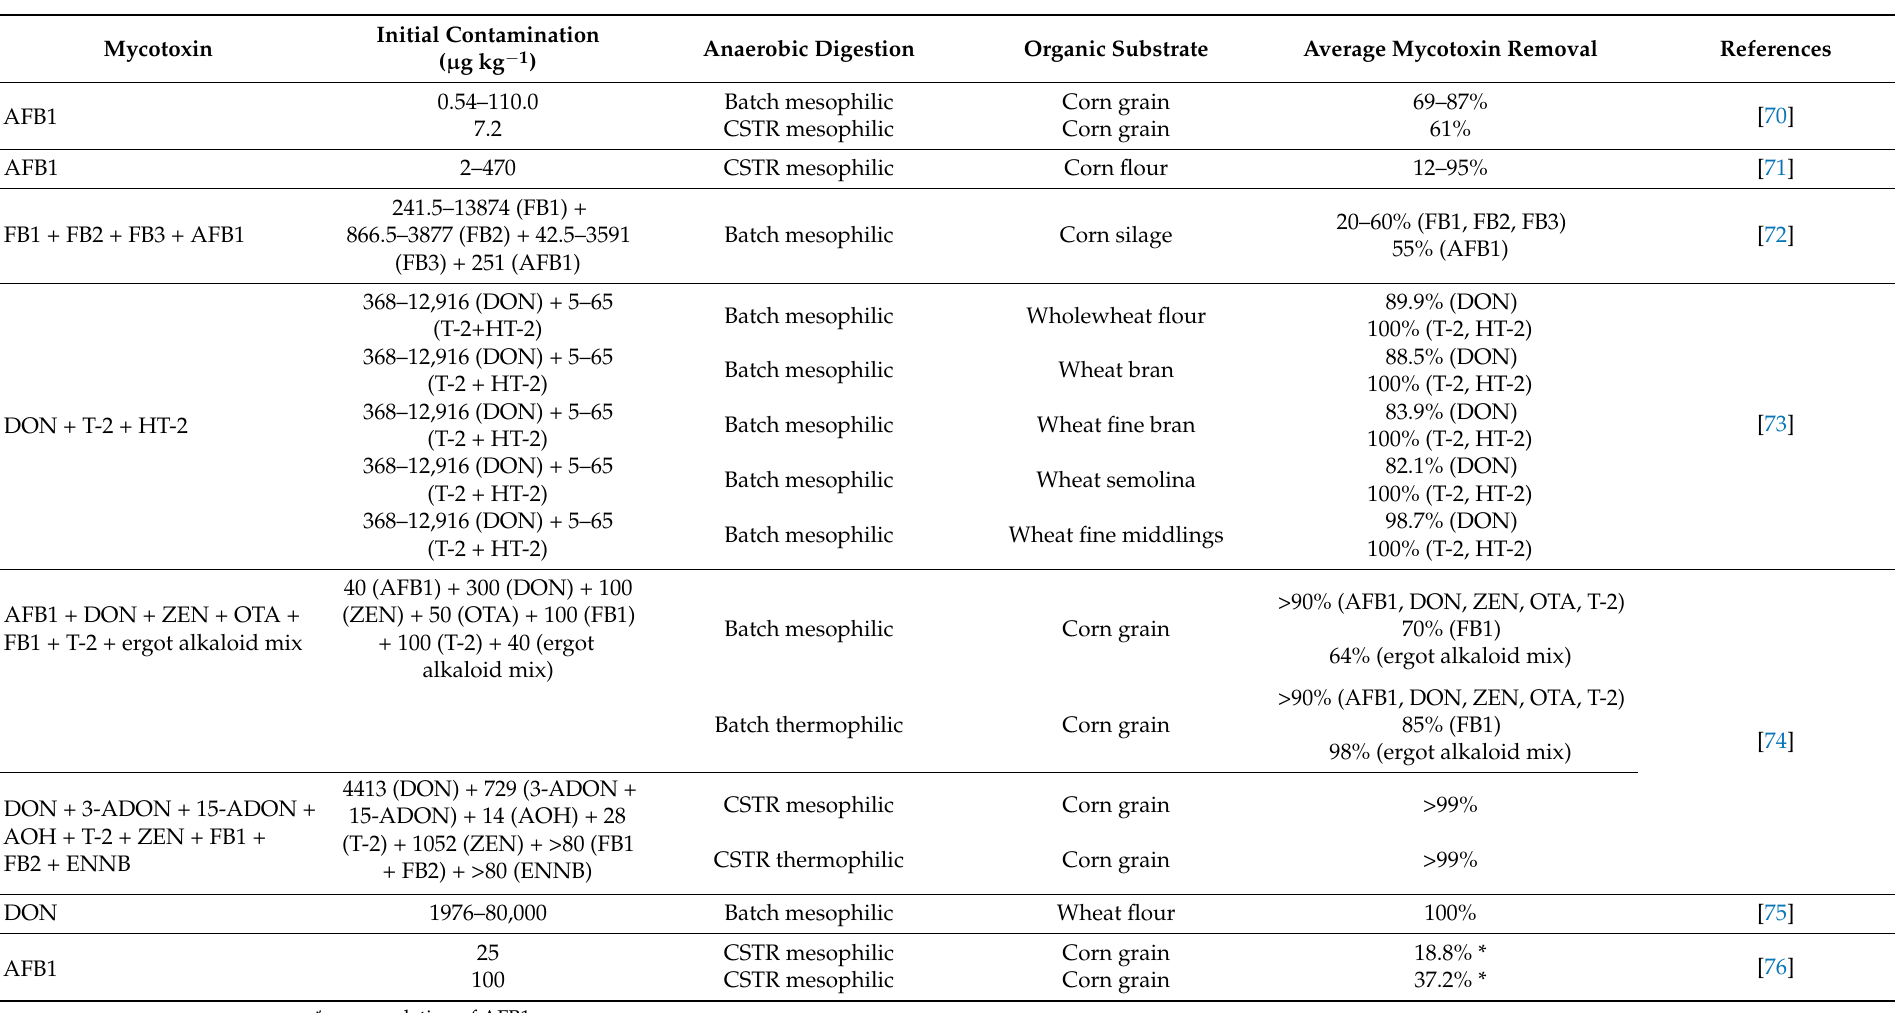
Table 4. Mycotoxins fate during